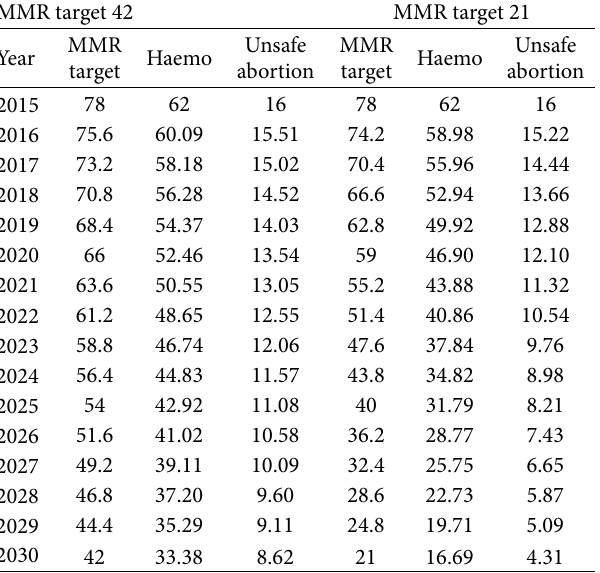
The target MMR due to physiological causes for 2030 is 42 in the first three columns and 21 in the last three columns.